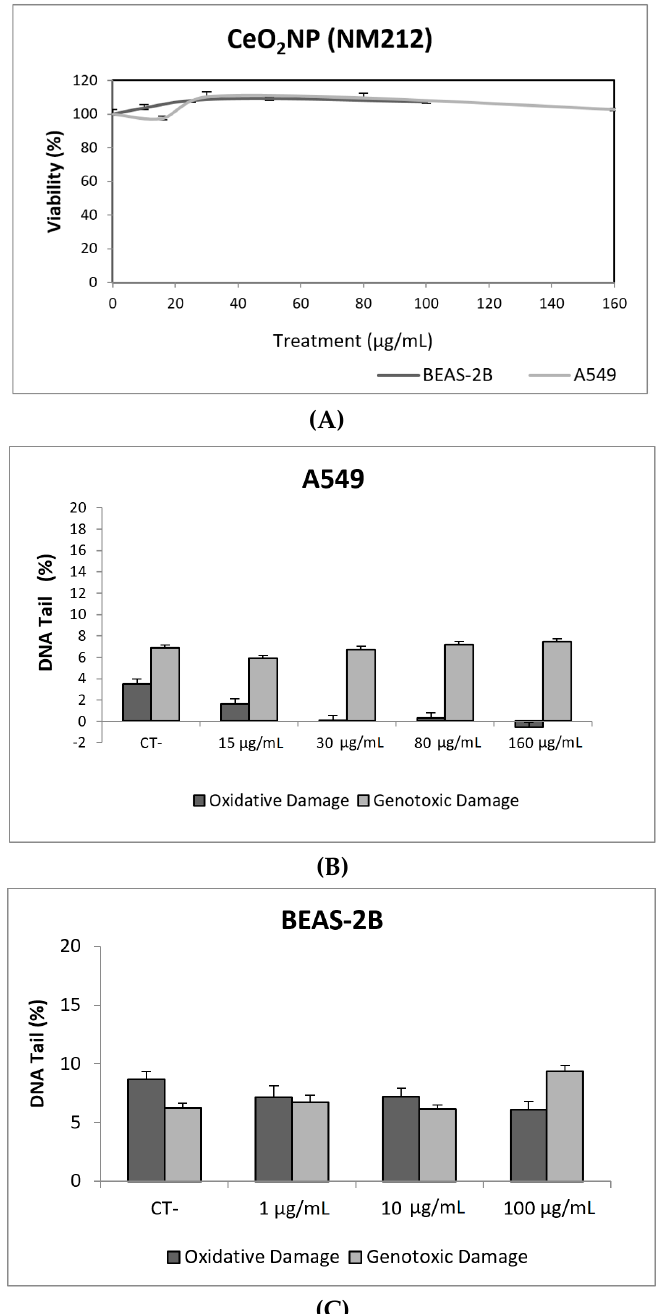
Figure 7. Results from the CeO 2 NPs (NM212), on A549 and BEAS-2B cells. ( A ) Toxicity curves for both cell lines. ( B ) Genotoxicity results obtained in A549 cells. ( C ) Genotoxicity results obtained in BEAS-2B cells. Genotoxicity data are plotted as mean ± SEM of two independent experiments. It should be noted that there is a significant reduction in the levels of oxidative DNA damage observed in the A549 cells. CT, control.